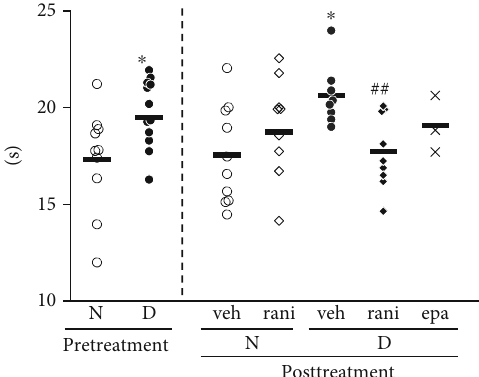
Figure 2: Amelioration of thermal perception threshold in planta pedis of diabetic rats treated with ranirestat. Thermal perception threshold increased in the diabetic rats 12 weeks after induction of diabetes. The increase was diminished in the diabetic rats after 6-week treatment with ranirestat. N: nondiabetic rats; D: diabetic rats; veh: rats treated with placebo; rani: rats treated with ranirestat; epa: rats treated with epalrestat. ∗ p < 0 : 05 compared with N or nondiabetic vehicle and ## p < 0 : 005 compared with diabetic vehicle. n = 15~18 at 12 w, n = 8~10 in groups treated with placebo or ranirestat, and n = 3 in rats treated with epalrestat. Bold horizontal line in each group demonstrates an average